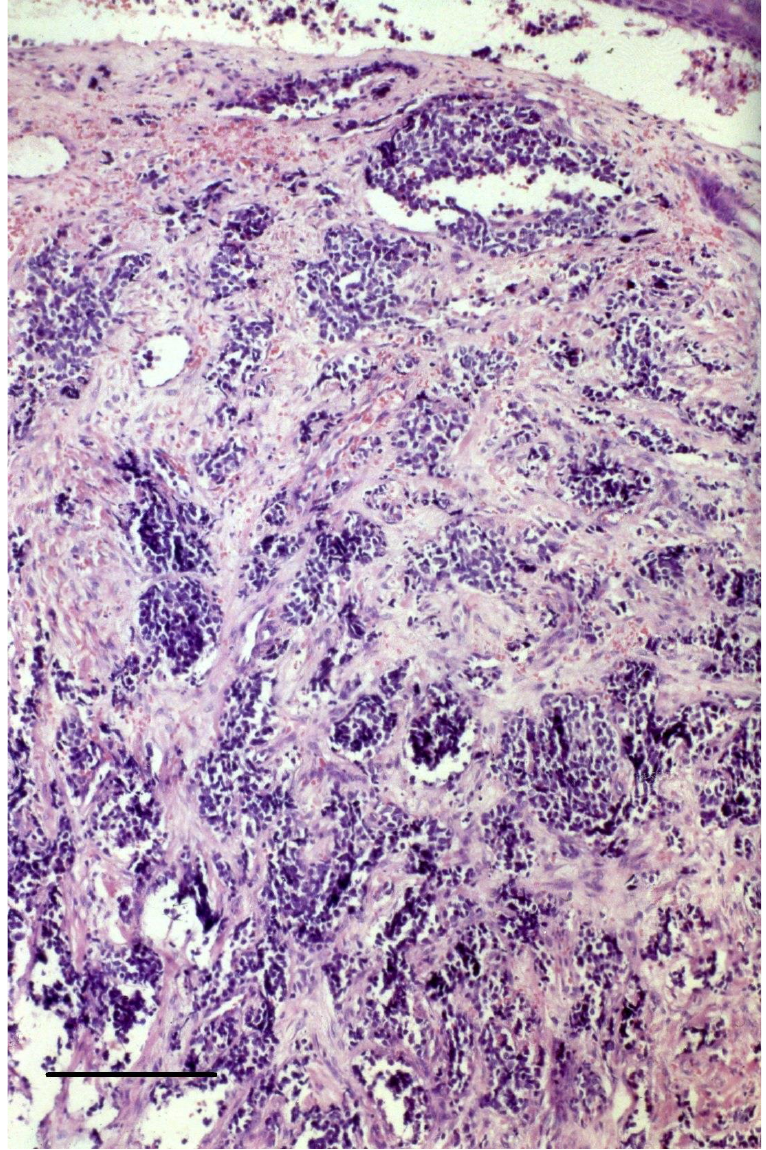
Figure 2. Hematoxylin-eosin stain of a primary MCC shows nests and loosely aggregated small round blue cells in the dermis. Magnification = 10 × 25. Bar = 100 μ m.